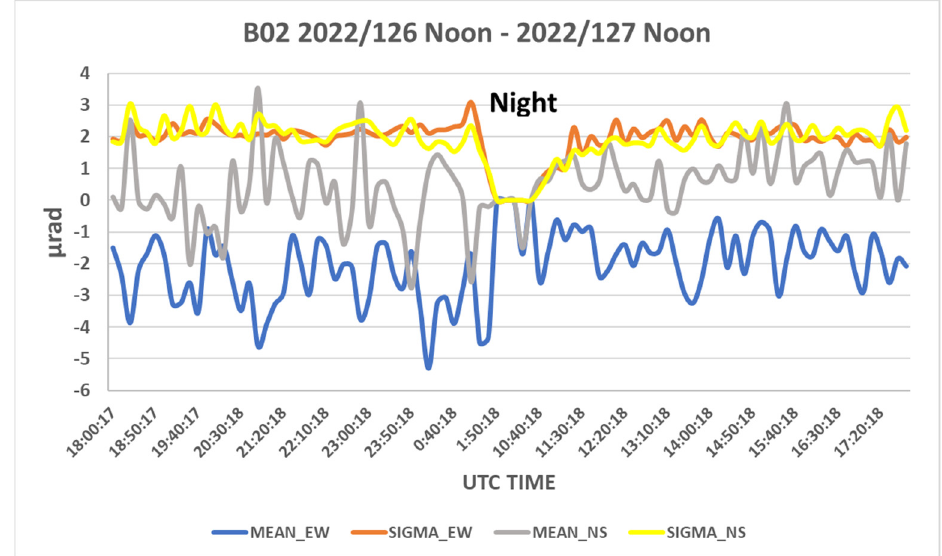
Figure 1. Landmark Measurements of GOES-18 INR Performance. Statistics show measured INR residual error in units of µradians for fully or partially illuminated ABI Full Disk scenes on 6 May 2022 for Band 2 plotted in chronological order and labeled by the Universal Time Coordinated (UTC) of the scene. Note: GOES-18 Preliminary, Non-Operational Data.